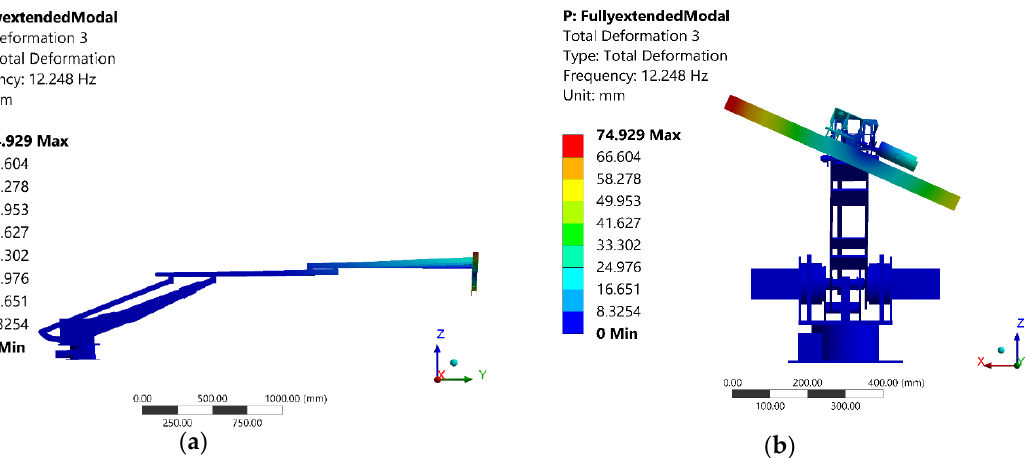
Figure 8. The 3rd mode shape of vibration for the Fully-extended configuration, arm is fixed at the base, ( a ) side view & ( b ) front view .